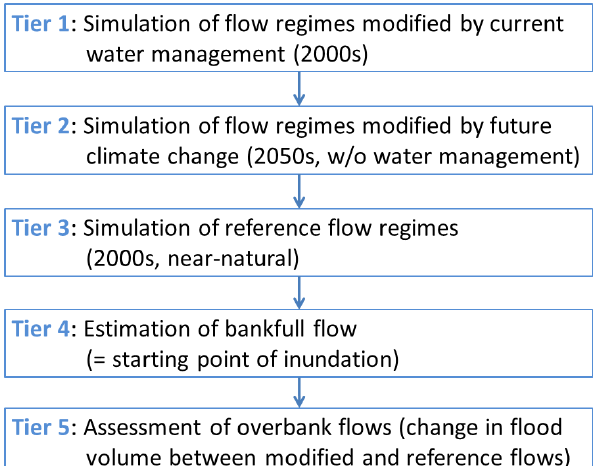
Figure 1. Schematic illustration of the steps taken in the quantitative analysis based on WaterGAP3